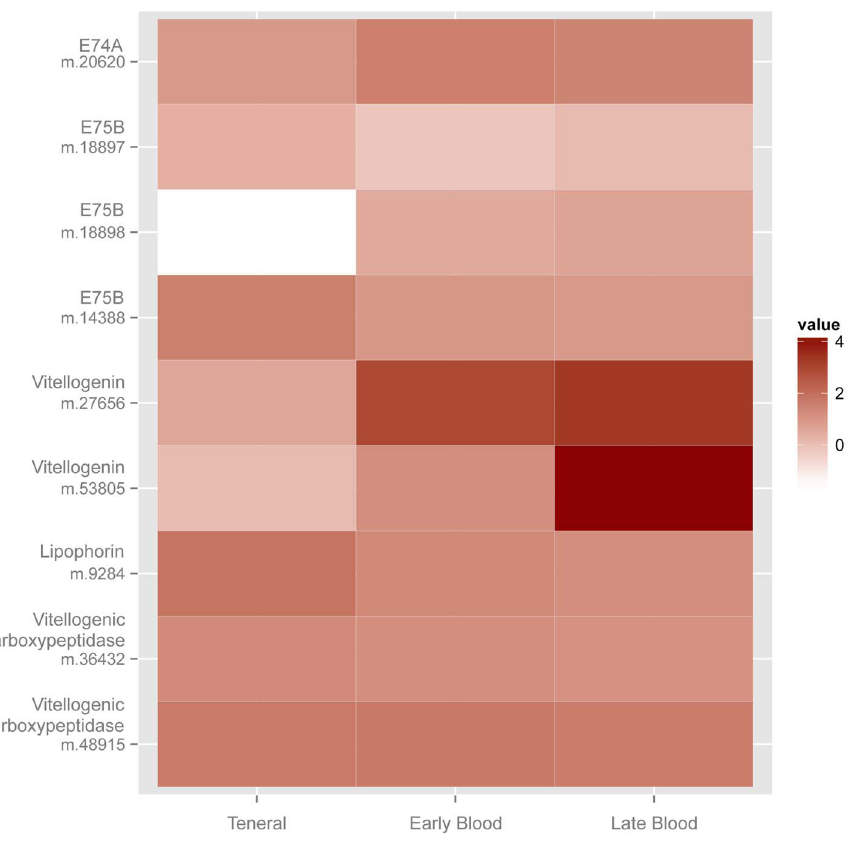
Figure 9. Heatmap showing comparative expression of Culicoidessonorensis vitellogenesis target genes in response to blood feeding. Early blood is 2, 6, 12 h post ingestion (pooled) and late blood is 36 h post ingestion, with Log 10 FPKM values indicated in legend. Further description of these genes can be found in Table 1, and detailed statistic and values of fold change can be found in Table 2.